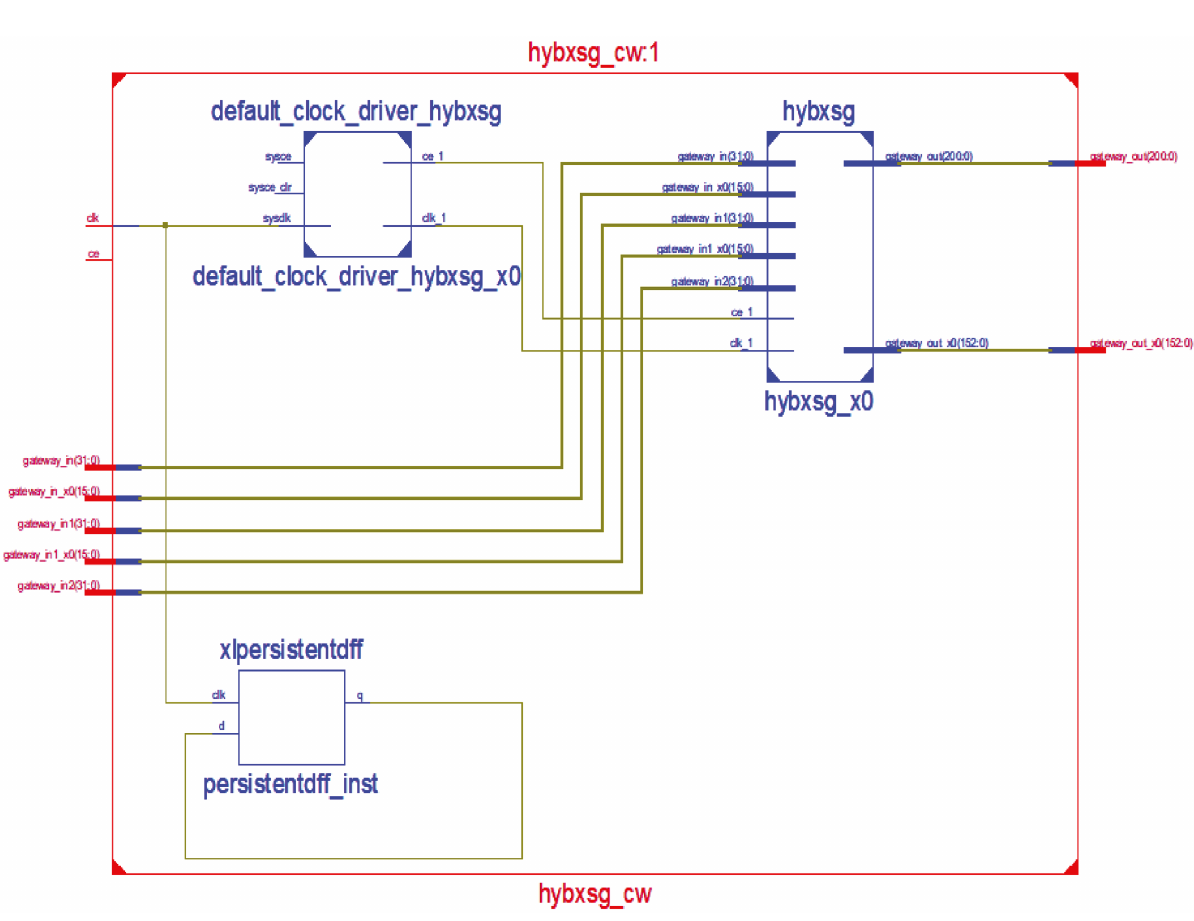
Figure 17: The generated RTL schematic. Table 6: Structure of an ANN controller with